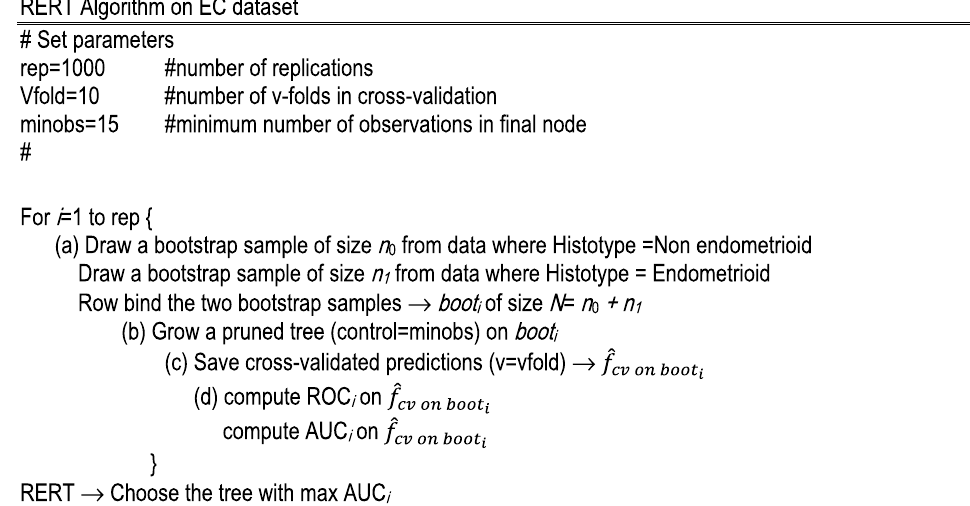
FIGO 2009 staging system, whilst the histological classification followed WHO criteria. Fasting blood samples were collected the day before surgery. Serum was separated by centrifugation at 1500 g for 10 minutes within 1 hour, frozen in liquid nitrogen and then stored at –80°C until analysis. EC patients’ charts were reviewed and all the clinico-pathological characteristics were collected in a dedicated data set (Table 1). Pre-surgical clinical stage was assessed on the basis of clinical evaluation and imaging by expert Gynecologic Oncologists. HE4 and CA125 serum concentrations measurements.